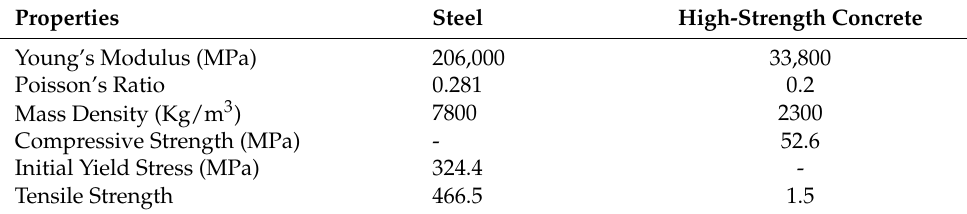
Table 1. Summary of the material properties considered in FEA.